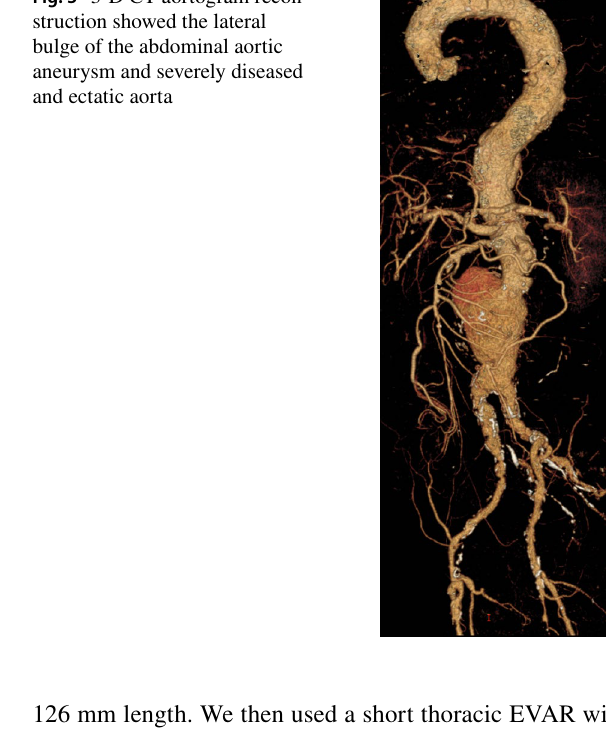
Fig. 3 3-D CT aortogram recon- struction showed the lateral bulge of the abdominal aortic aneurysm and severely diseased and ectatic aorta